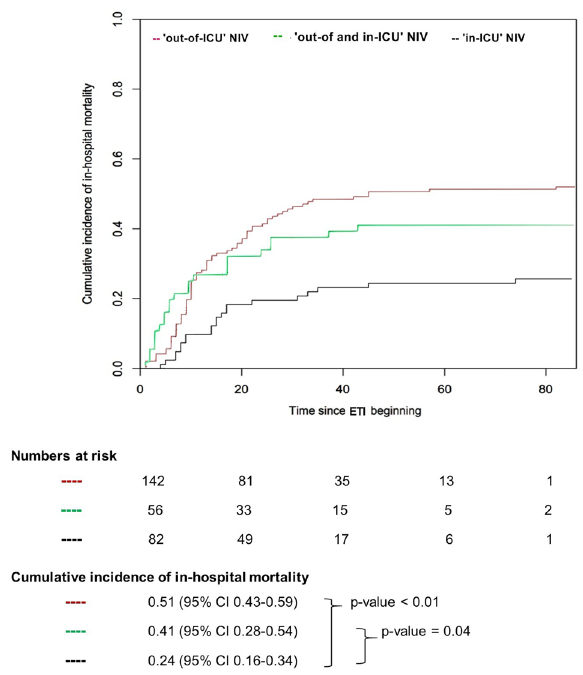
Figure 4. In-hospital mortality stratified by hospital location. p value Gray’s test was used for calculating equality of cumulative incidence function. When NIV was applied exclusively in medical wards, respiratory high dependency units or Emergency Department, patients were included in the ‘out-of-ICU’ group. When NIV was applied before and after ICU admission, patients were included in the ‘out- and in-ICU’ group. When NIV was applied exclusively after ICU admission patients were included in the ‘in-ICU’ group. NIV: non-invasive ventilation; ICU: intensive care unit; ETI: endotracheal